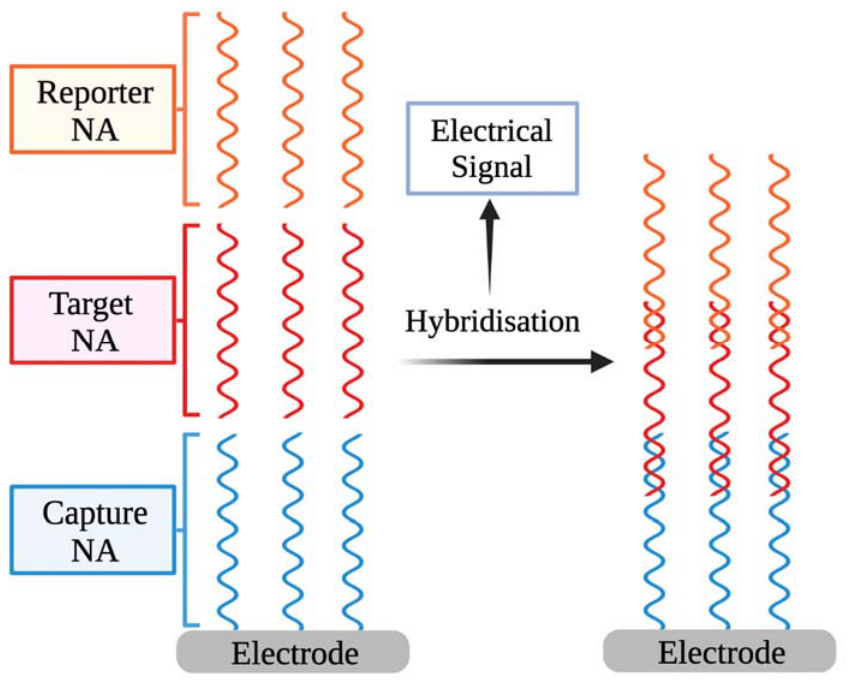
Figure 2. The basic outline of electrochemical biosensors for detecting NA